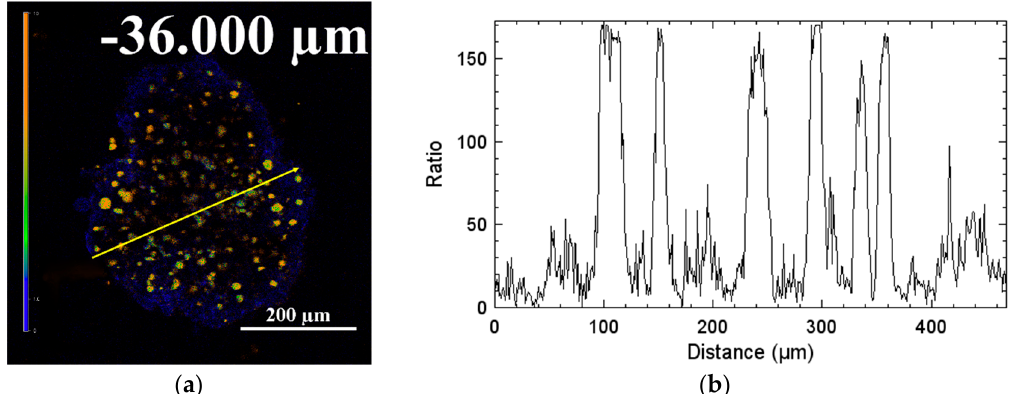
Figure 8. ( a ) Pseudocolor ratiometric intensity images (I F610 / I F545 ) of sectional MCTs at depth of − 36 μ m and ( b ) intensity ratio along with profiles spanning labeled cells, as indicated by the lines (yellow). The color bar from blue to orange corresponds to the increase of intensity ratio from 0 to 200. Scale bar = 200 μ m.